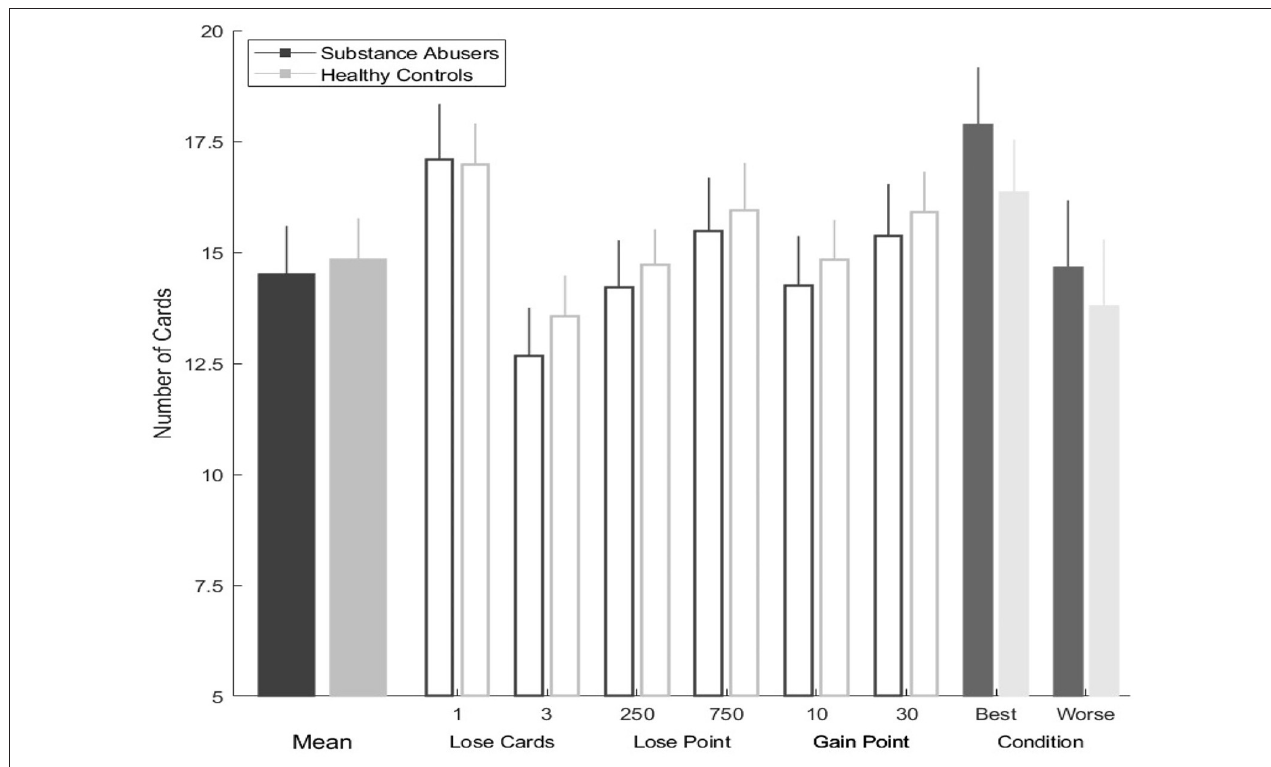
FIGURE 4 | Columbia card task hot version performance in each condition by group.